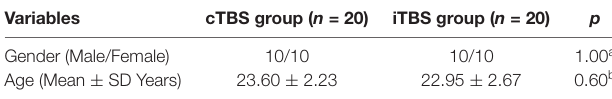
TABLE 1 | Demographics of the participants.